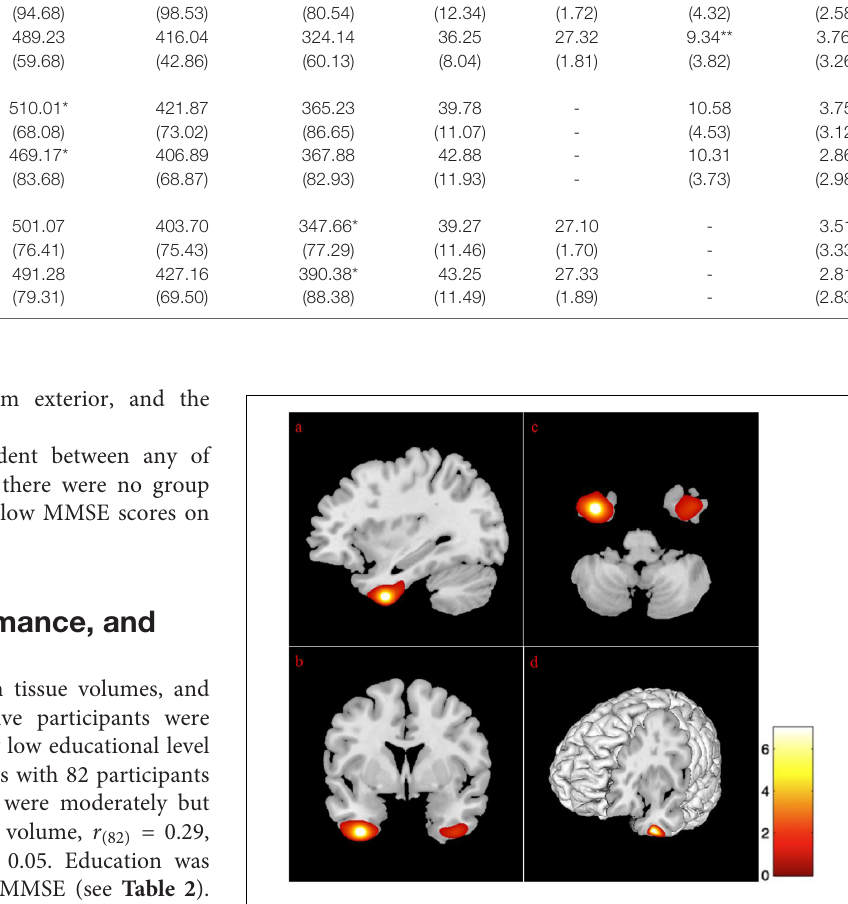
FIGURE 1 | Correlation between gray matter regions and age. The position of the axes indicates a negative correlation between the left hippocampus (MNI coordinates: − 18, − 10, − 22) and age. Color bar indicates the t -score for the regression slopes. (A) Sagittal plane, (B) coronal plane, (C) axial plane, and (D) 3D illustration, p = 0.001. MNI, Montreal Neurological Institute.